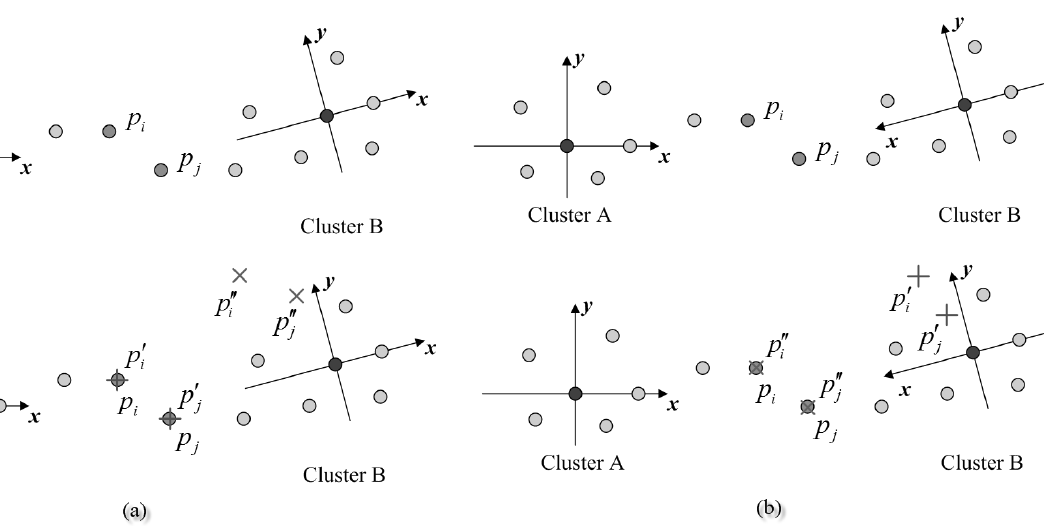
Figure 4. The process of coordinate system registration. (a) The right-hand coordinate hypothesis H : cluster B is in the right-hand coordinate system; (b) The left-hand coordinate 1 hypothesis H : cluster B is in the left-hand coordinate 2